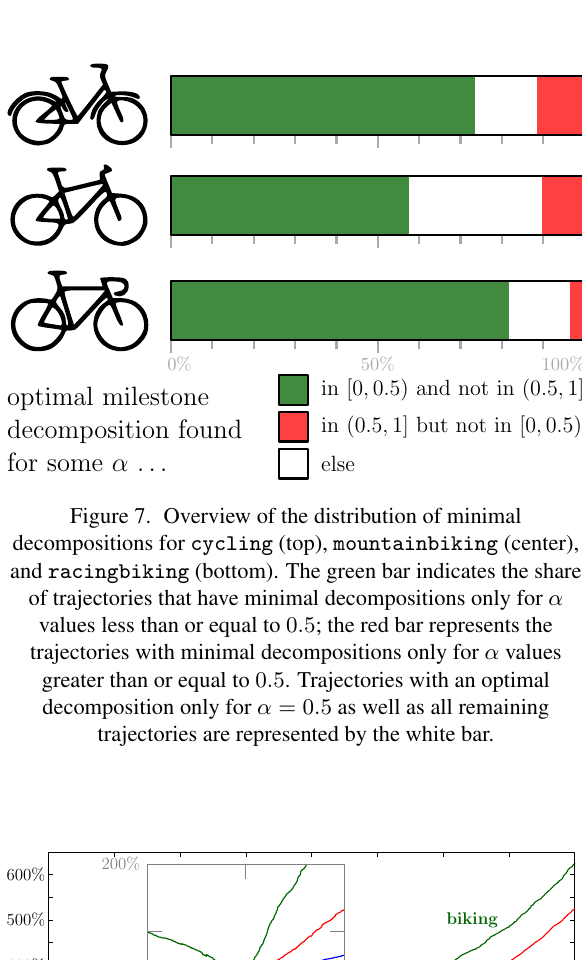
Figure 6. Excerpt of the trajectory of Fig. 4. Road segments of favored type are colored blue, those of unfavored type are colored red. For this subpath, a decomposition with α = 0 . 5 requires three milestones ( × ) while already two milestones are sufficient with α = 0 . 38 ( ◦ ). The road segment marked with “!” causes an extra milestone for every decomposition with α ≥ 0 . 48 . Note that this implies that the subpath between the two circles is an optimal path for α = 0 . 38 but not for α = 0 . 5 .